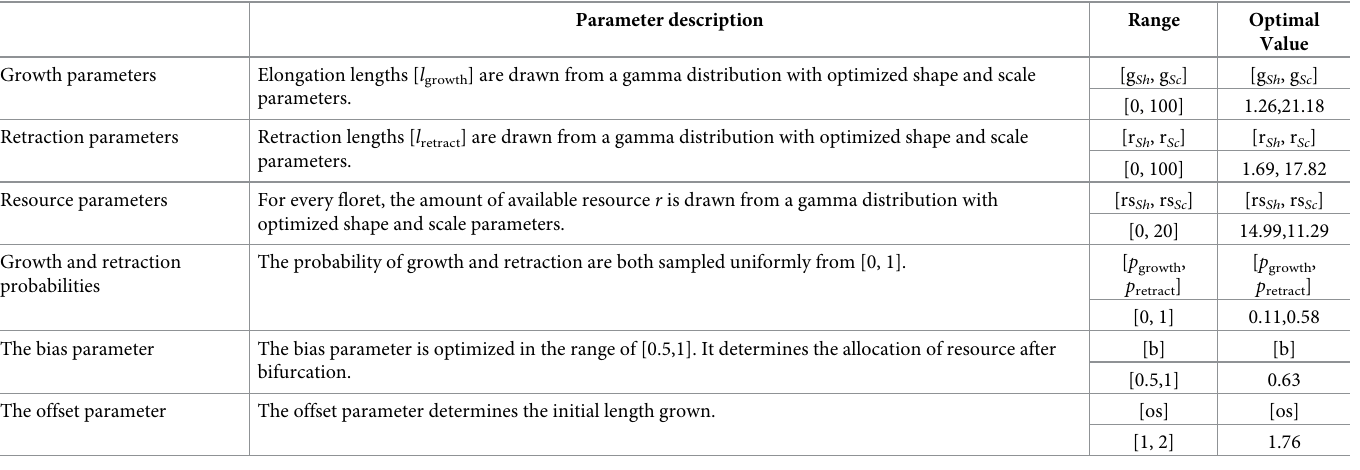
Table 3. Parameters of the floret-generator with optimized values.